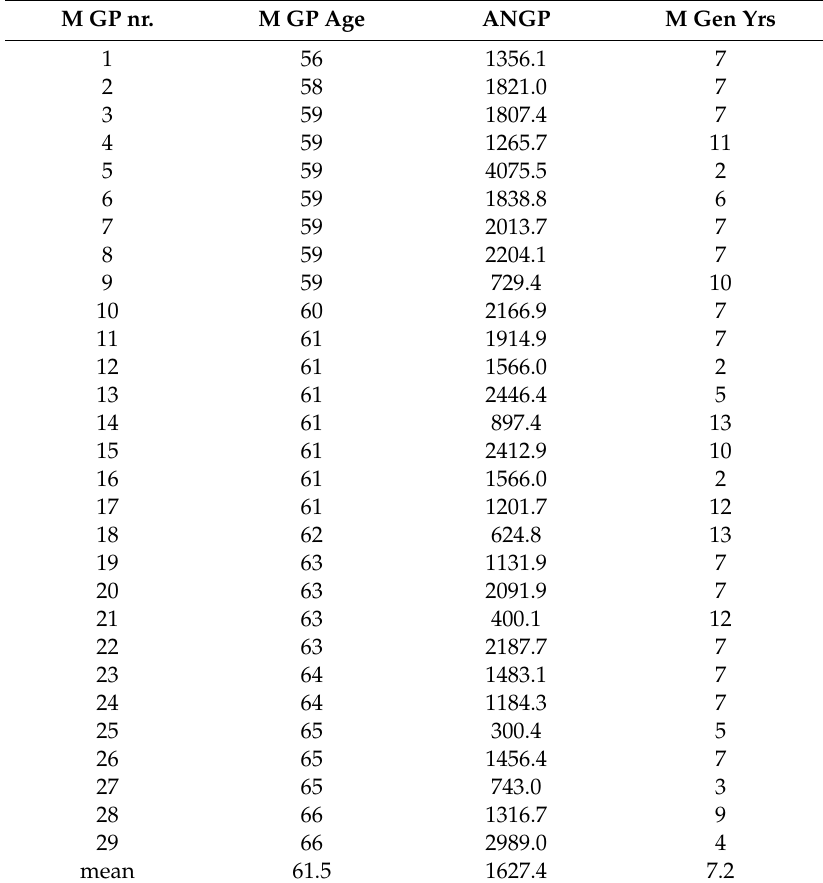
Table 2. Generic drug prescription of male GPs ( n = 29).